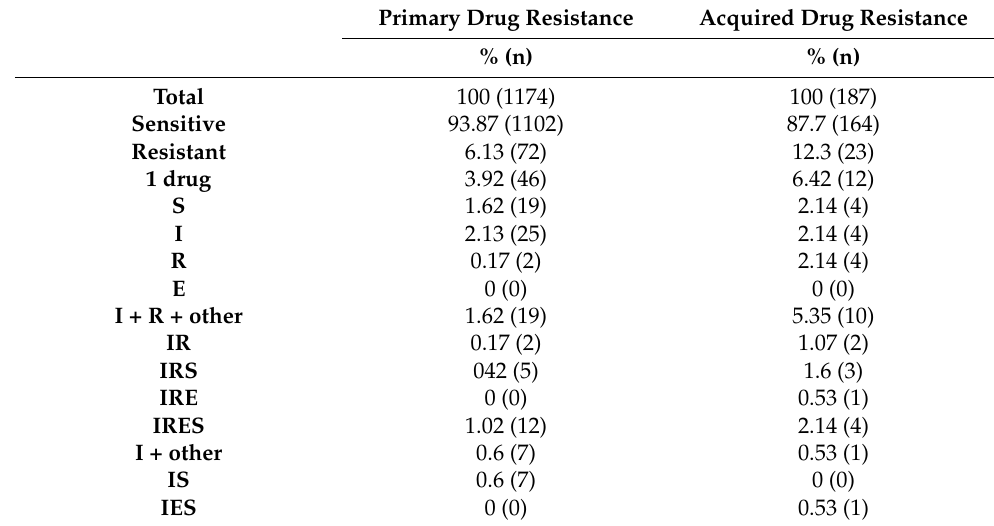
Table 4. Resistance patterns of Mycobacterium tuberculosis strains isolated from newly diagnosed patients (primary drug resistance) and from previously treated patients (acquired drug resistance) in Poland in 2020. Primary Drug Resistance Acquired Drug Resistance % (n) % (n) Total 100 (1174) 100 (187) 93.87